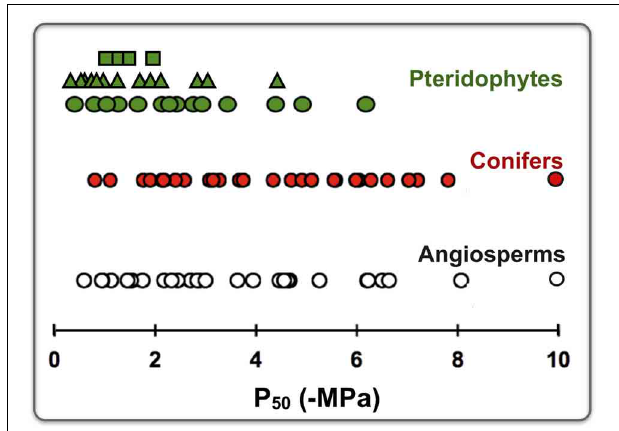
FIGURE 2 | The water potential causing 50% loss of hydraulic conductivity ( P 50 ) collected from a sampling of conifers,